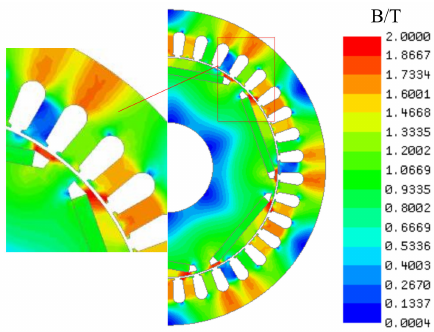
Figure 3. Distribution of flux-density under rated-load condition ( t = 0.08 s).